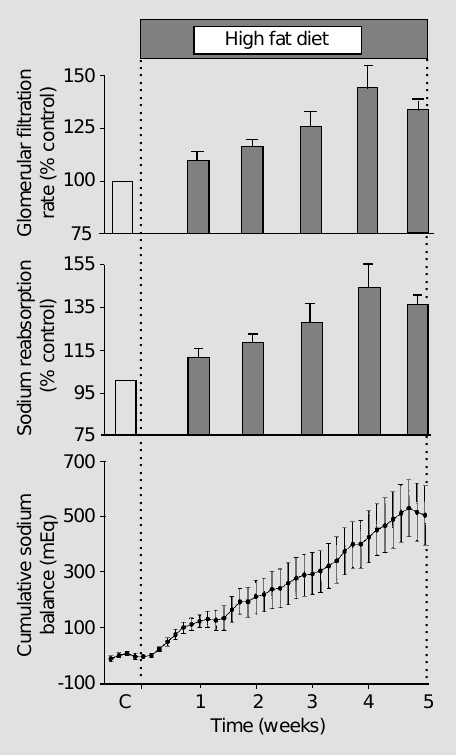
Figure 3 - Effects of 5 weeks of a high fat diet on glomerular fil- tration rate, renal sodium reab- sorption, and cumulative sodium balance in dogs. C, Control. (Re- drawn from Ref.